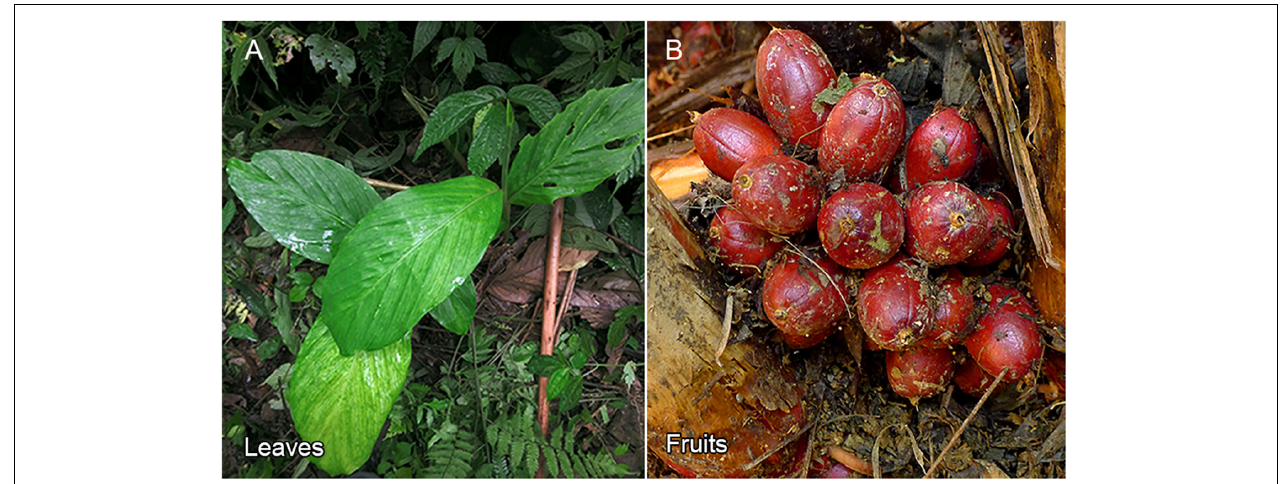
FIGURE 1 | Morphological features of A. tsao-ko. (A) The leaves of A. tsao-ko . (B) The fruits of A. tsao-ko